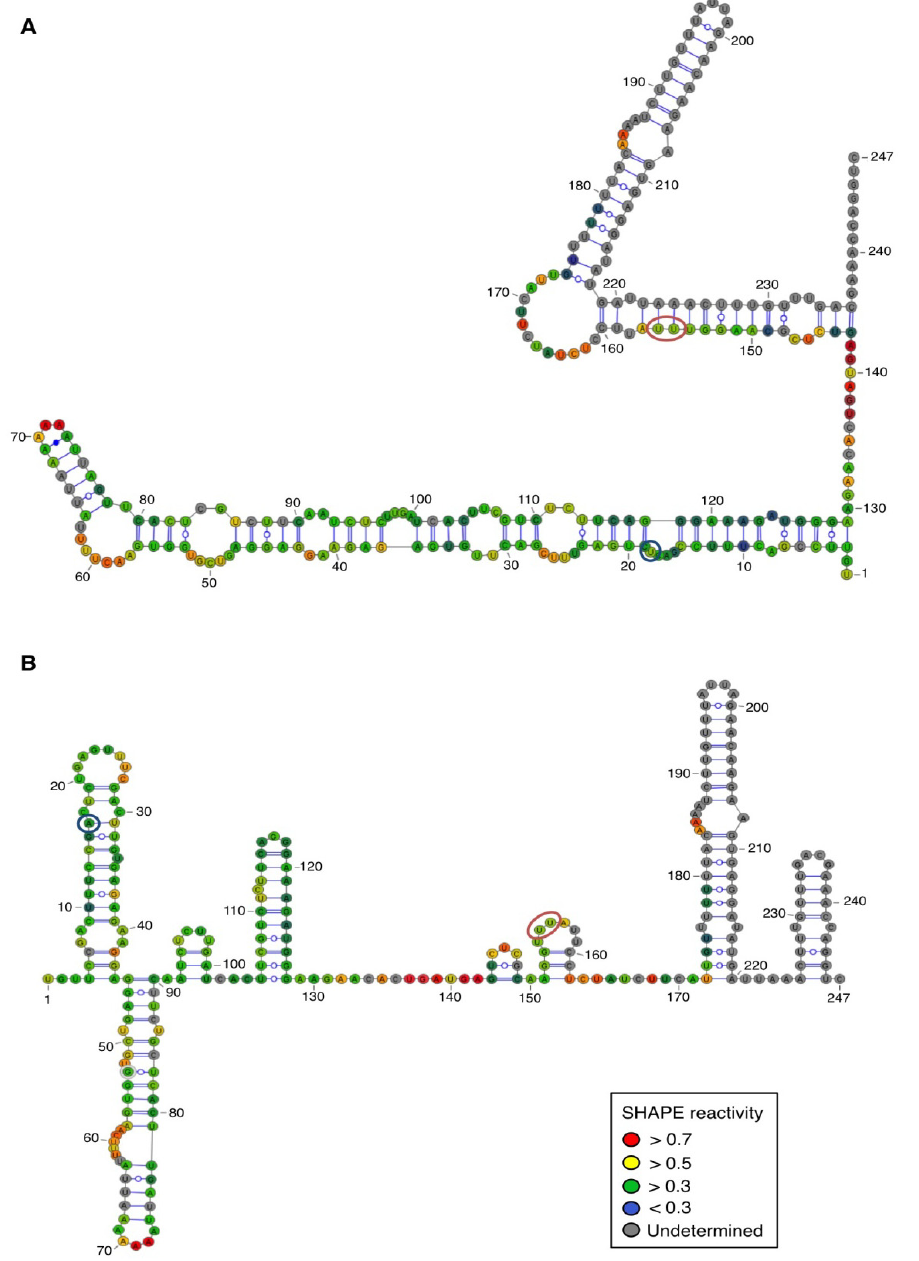
Figure 4. Secondary structure models of ASBVd (+) based on the SHAPE analysis. ( A ) and ( B ) are the two secondary structure models proposed for ASBVd (+). The color of the circle surrounding each nucleotide reveals their relative reactivity to 1M7 in the presence of 10 mM Mg 2+ , as mentioned in the box. High reactivity reflects single-stranded region, while paired nucleotides are not reactive. Nucleotides for which the reactivity could not be determined are shown in grey and correspond to the primer binding site, or to nucleotide right 3' to the primer for which the electrophoresis resolution is not good enough, or to RT stops. The same experiments were carried out without Mg 2+ and differences in reactivity are represented on the scheme: nucleotides circled in red show enhanced reactivity in the presence of Mg 2+ , and those in blue are less reactive. The models were designed using VaRNA